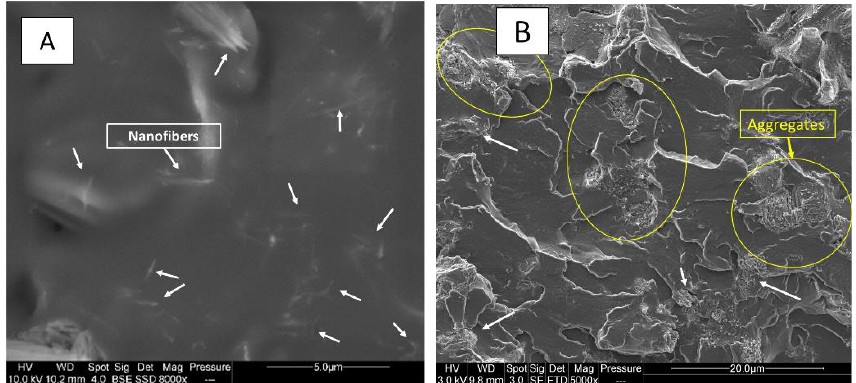
Figure 6. SEM pictures of PUE/APP/S9 and PLA/APP/S9 (( A ) PUE/APP/S9 ×8000; ( B ) PLA/APP/S9 ×5000).